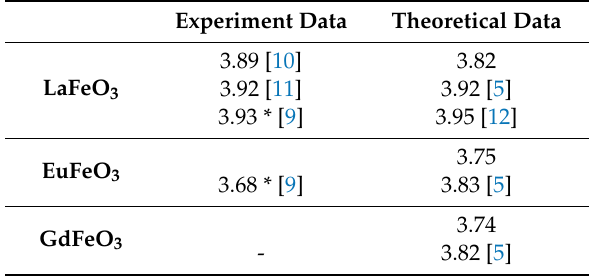
Table 1. Comparison between our calculated, and reported the experimental and theoretical results in the literature for the lattice parameters of LaFeO 3 , EuFeO 3 , and GdFeO 3